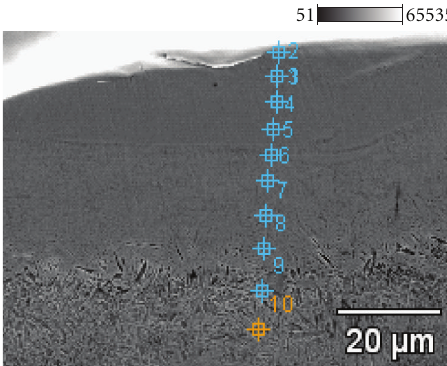
Figure 11: SEM surface layer image after the alloying with the electrode of alloy steel 1H18N9 ( I = 32A, Ti = 25 μ s); measuring points (Table 2) have been marked.